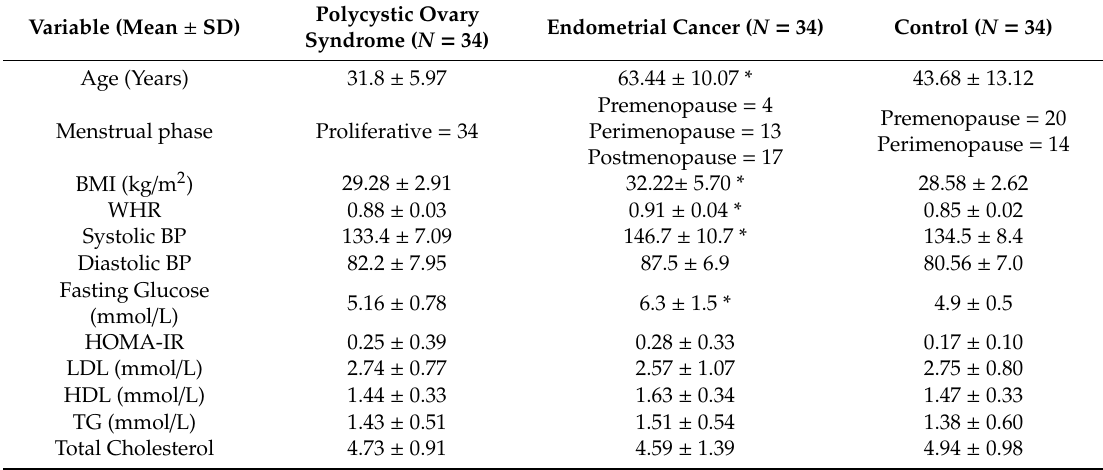
Table 1. Patient